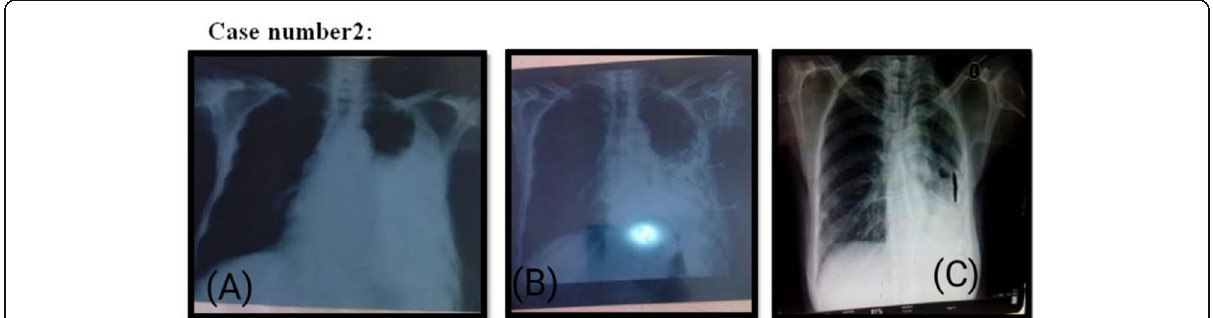
Fig. 2 a Plain chest X-ray PA view showing massive left-sided pleural effusion before drainage. b Plain chest X-ray PA view showing evacuation of the effusion with the pigtail pleural catheter seen in place. c Plain chest X-ray PA view showing complete evacuation of the effusion after pleurodesis by tranexamic acid (case